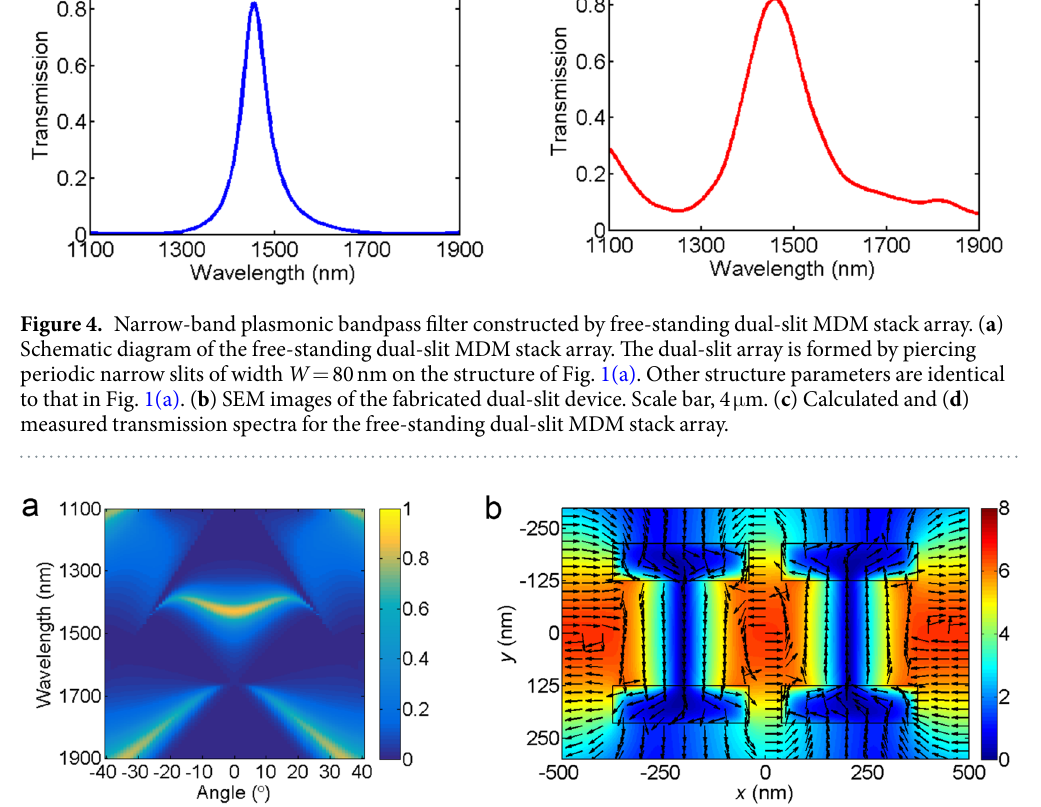
different from that in experiment. Second, there are the inevitable roughness of structure surface and imper- fect fabrication process. Third, the microscope objective with a non-zero numerical aperture in the experiment measurement brings oblique incidence, widening the line shape of transmission peak and introducing additional transmission peaks. Figure 5a presents transmission spectra under different incident angles in the dual-slit MDM structure. The wavelength position 1454 nm of transmission has a little change and keeps high transmission efficiency in the incident angle ranging from − 20° to 20°. It is noteworthy that the transmission peak of dual-slit MDM structure keeps narrow bandwidth. Due to similarity between Fig. 5a and Fig. 1d, we infer that the physical mechanism of transmission peak in the dual-slit structure is nearly identical to that of single-slit structure. The calculated electromagnetic field distribution at the transmission peak shown in Fig. 5b verifies above viewpoint. The elec- tromagnetic field distribution in Fig. 5b is almost identical to that in Fig. 3a. The only difference is that second slit affecting the antisymmetric mode of MDM stack array and decreasing the effective permittivity of the waveguide